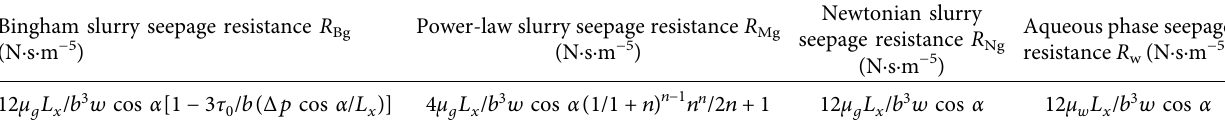
Table 1: Expressions of seepage resistance for fluids with different flow patterns.